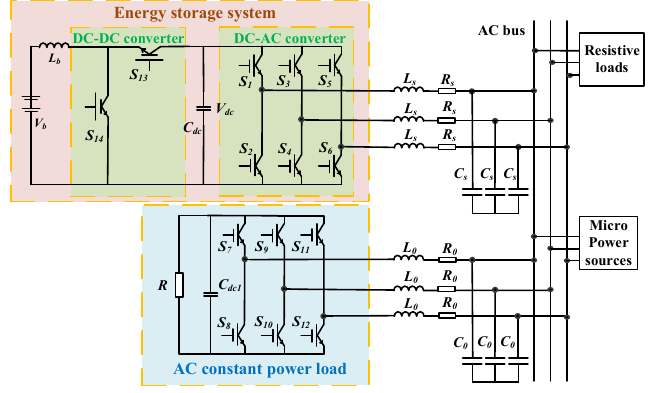
Figure 1. The schematic of an islanded AC microgrid. The rectifier of AC CPL uses a PI control strategy to ensure that the voltage value on both sides of the resistance is constant. Consequently, the active power utilized by AC CPL can be assumed to remain constant. As the bus RMS voltage increases, the current of the AC CPL will decrease. On the contrary, when the voltage decreases, the current simultaneously increases. As can be seen in Figure 2, a negative value is obtained when the RMS voltage changes are divided by the RMS current changes, satisfying Δ V RMS / Δ I RMS < 0. The AC CPL exhibits negative impedance characteristics. The negative impedance characteristics of AC CPLs, which are equal to positive feedback when the bus voltage swings, make the system more unstable.